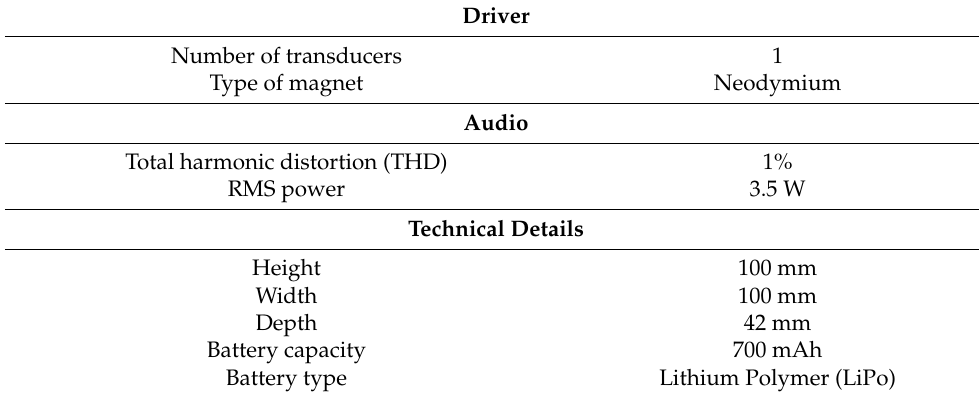
Table 1. Technical characteristics of the portable Bluetooth acoustic emitter used for the generation of the acoustic